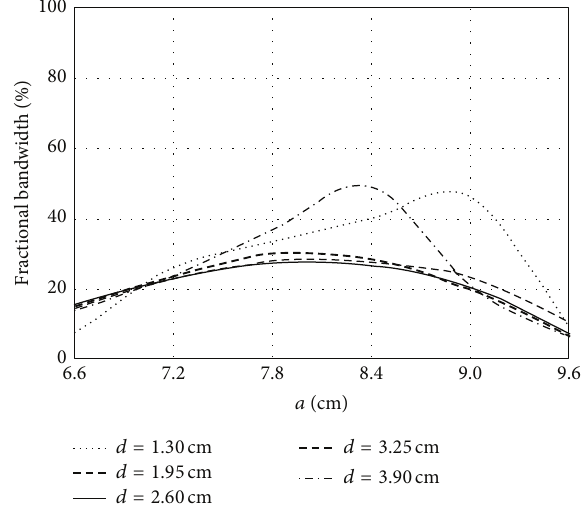
Figure 2: Fractional bandwidths of the resonant frequency at 2.3 GHz versus 𝑎 as a function of 𝑑 ( 𝑟 𝑐 = 1.30 cm and ℎ = 3.90 cm).